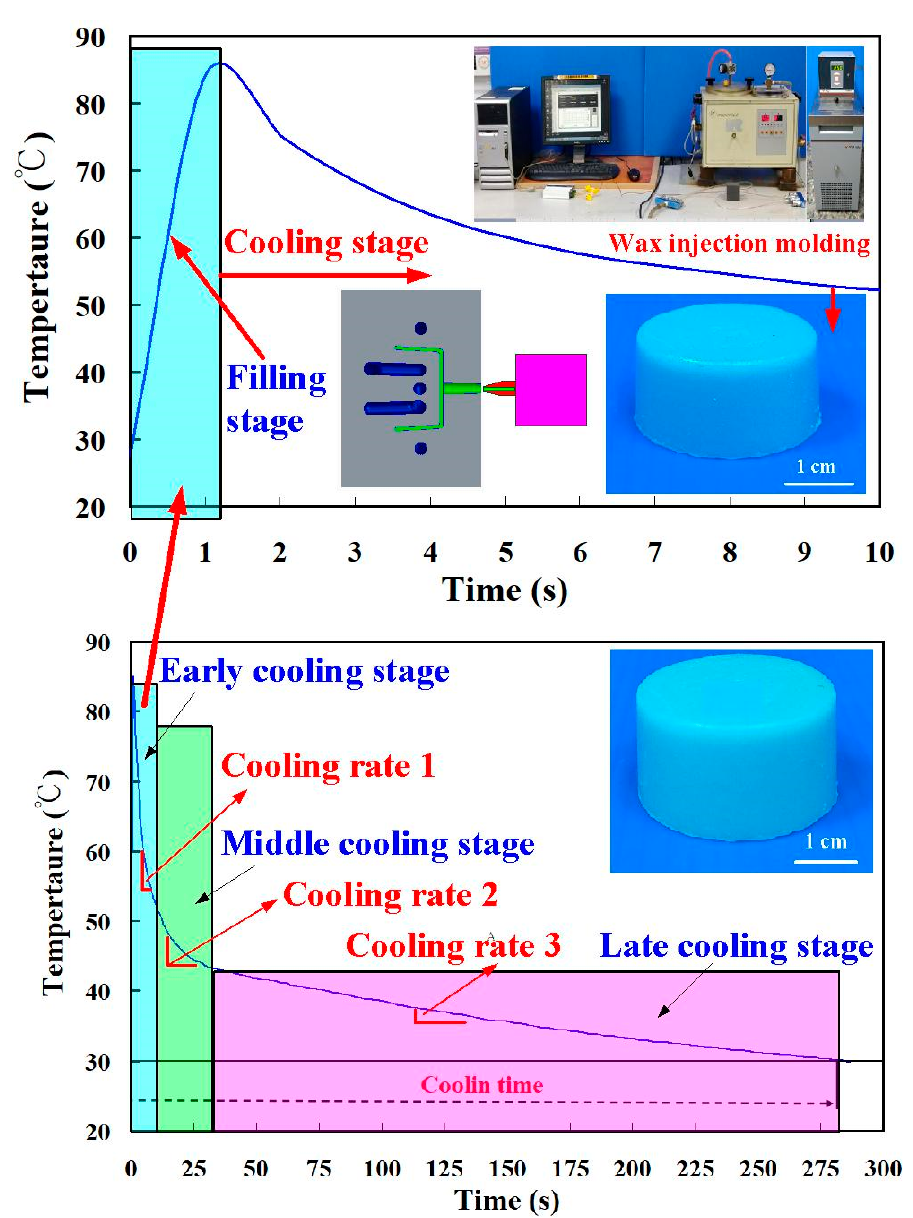
Figure 13. Typical temperature history of the injection molded part.